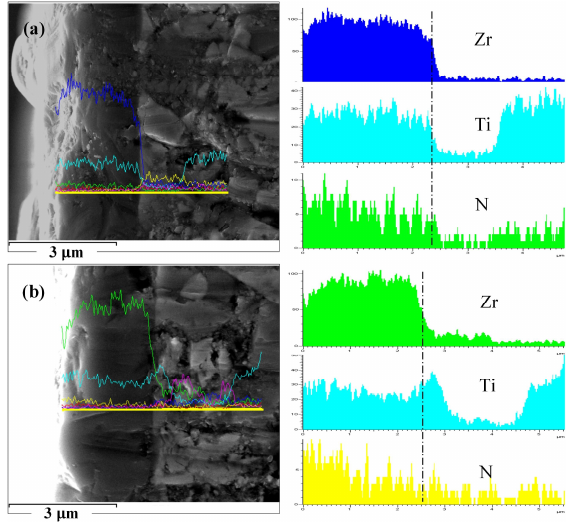
Figure 2. The SEM micrographs of sample cross section and EDX line scanning analysis results of Zr, Ti, and N elements of the coatings: ( a ) SZT (single-layer ZrTiN coating); ( b ) ZGC (property-component gradient ZrTiN coating).